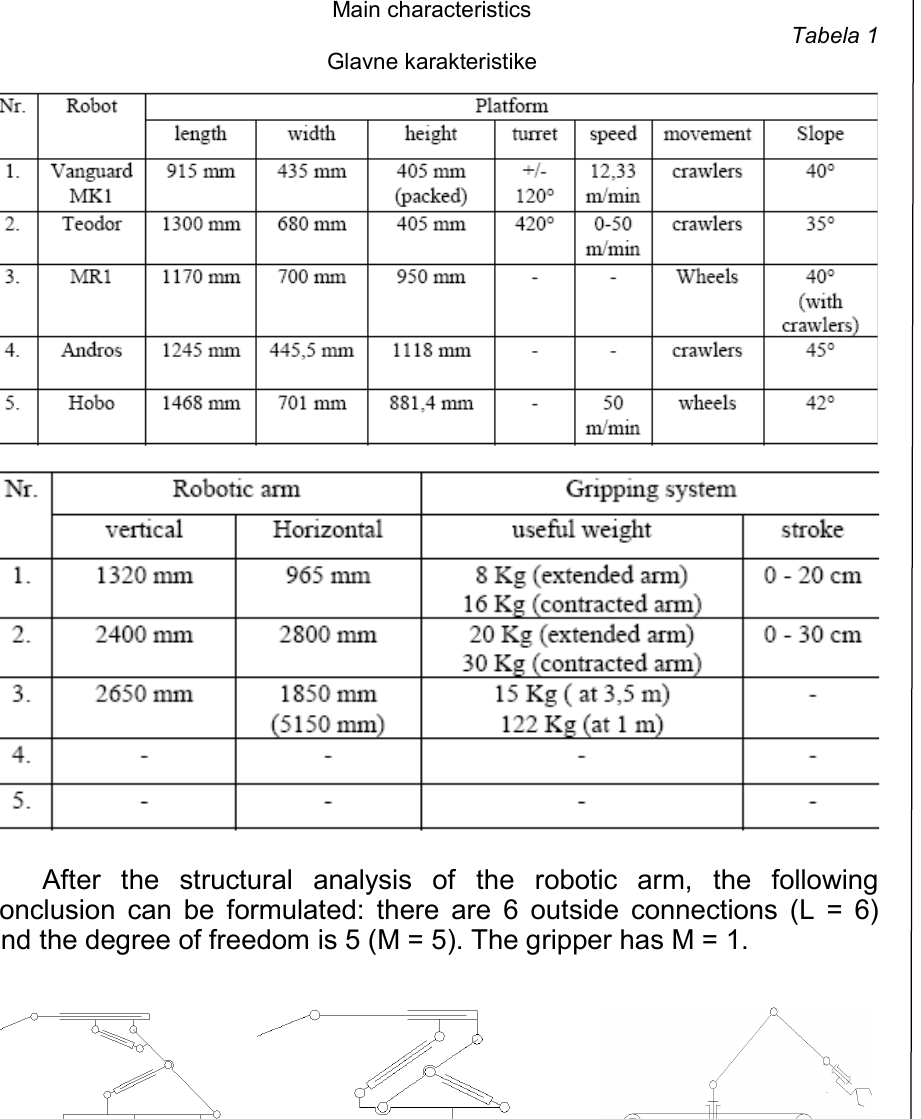
Figure 2 – Structural